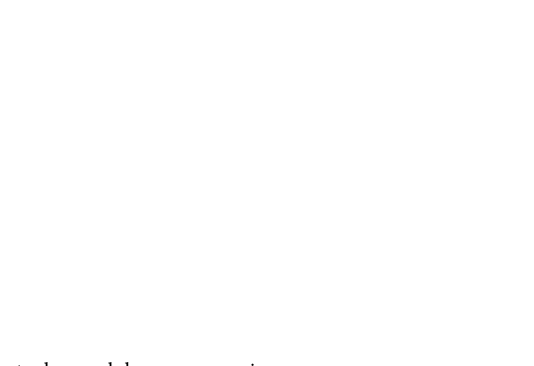
Table 1. Samples selected for the mitochondrial cytochrome b locus